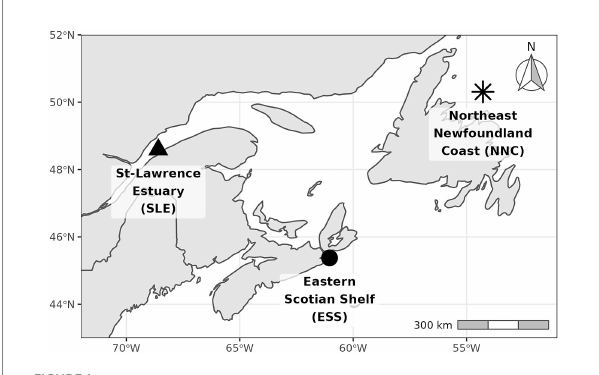
FIGURE 1 Pandalus borealis collection sites. Map of the southeast of Canada with the three geographic locations where shrimp used in this study originated from. Collection conditions are described in Supplementary Table